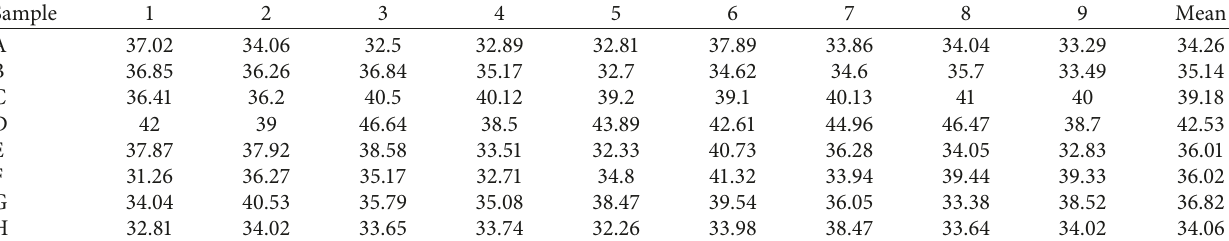
Figure 3: Average percentage of acid insoluble material in hematite ore of Pokhari determined gravimetrically. Samples were collected from eight channels each consisting of nine samples. The values shown here are average of these nine samples of each channel. The channels are arbitrarily graded from A to Table 3: Iron content values of different samples of hematite ore. The mean value in the table represents the mean of nine samples for each channel assigned from A to H.